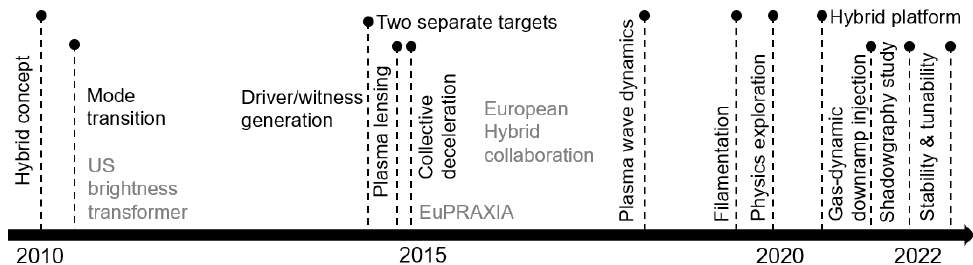
Figure 11. Timeline of hybrid LWFA → PWFA research, with selected experimental highlights. Mile- stones for the approach are being reached at an increasing rate based on the full experimental establishment of the hybrid plasma accelerator platform at the beginning of the